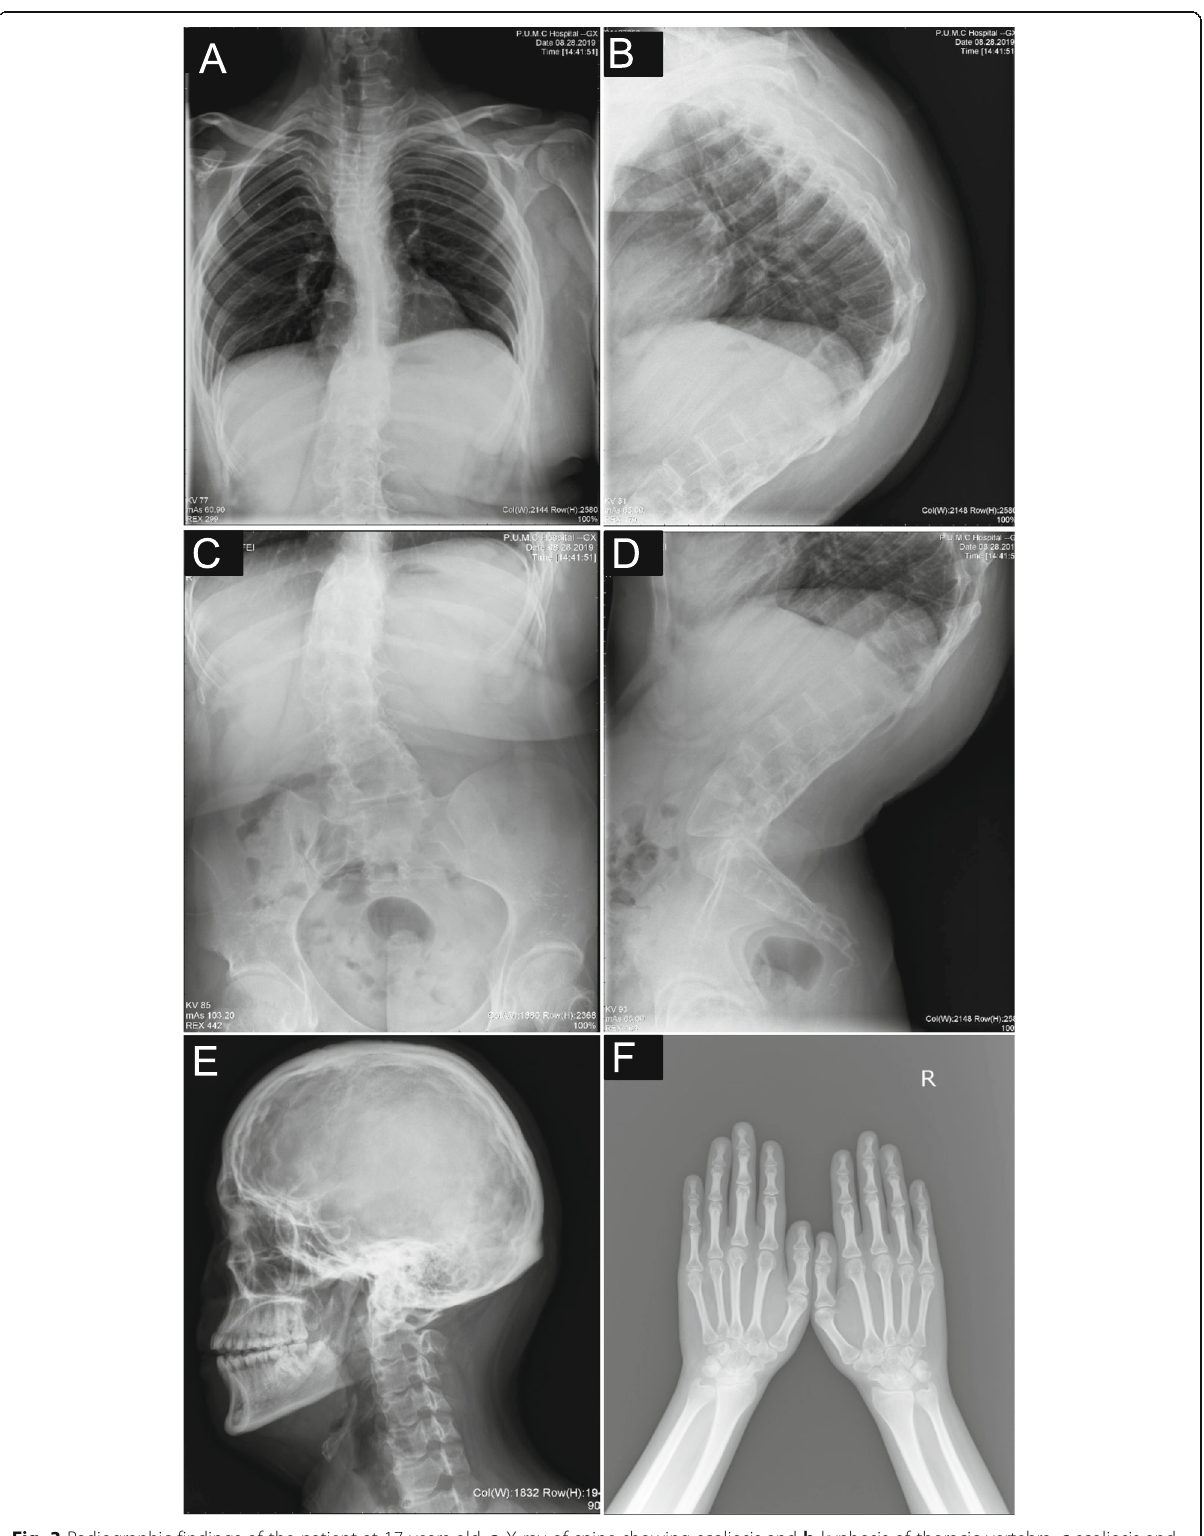
Fig. 3 Radiographic findings of the patient at 17 years old. a X-ray of spine showing scoliosis and b kyphosis of thoracic vertebra, c scoliosis and d kyphosis of lumbar vertebra. e X-ray of skull showing copper-beaten appearance. f X-ray of hands showing